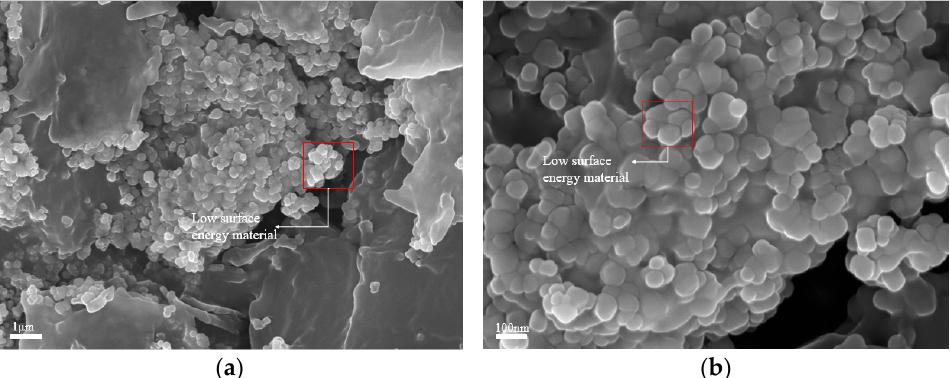
Figure 7. Environmental Scanning electron microscope images of superhydrophobic material surface: images ( a ) and ( b ) are under ×5000 and ×50,000 magnification scales, respectively.